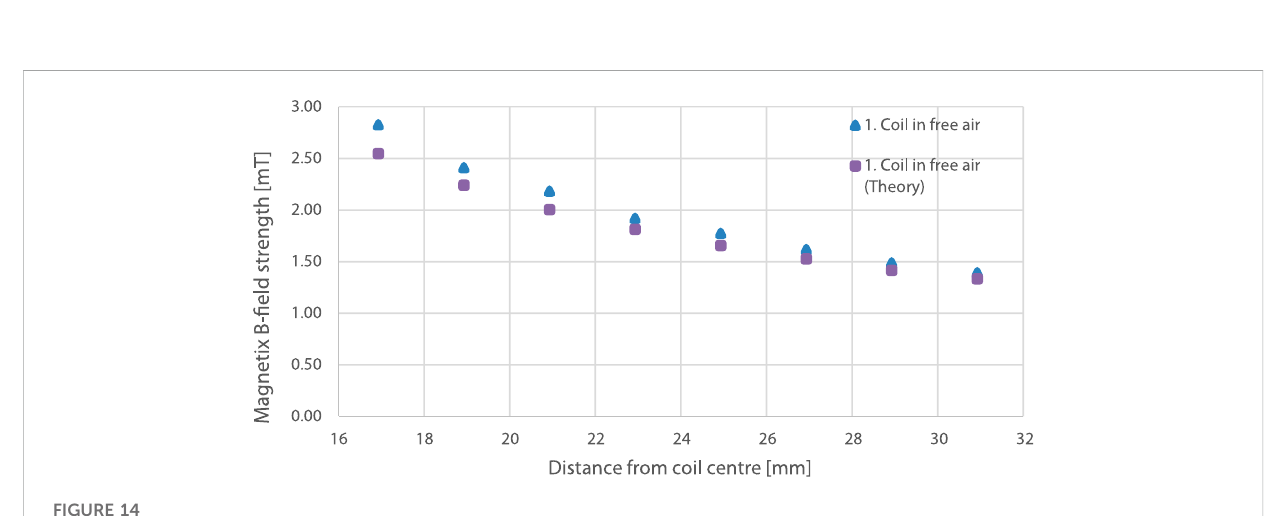
FIGURE 14 Magnetic B- fi eld strength that was measured and the theoretical values computed with Eq.